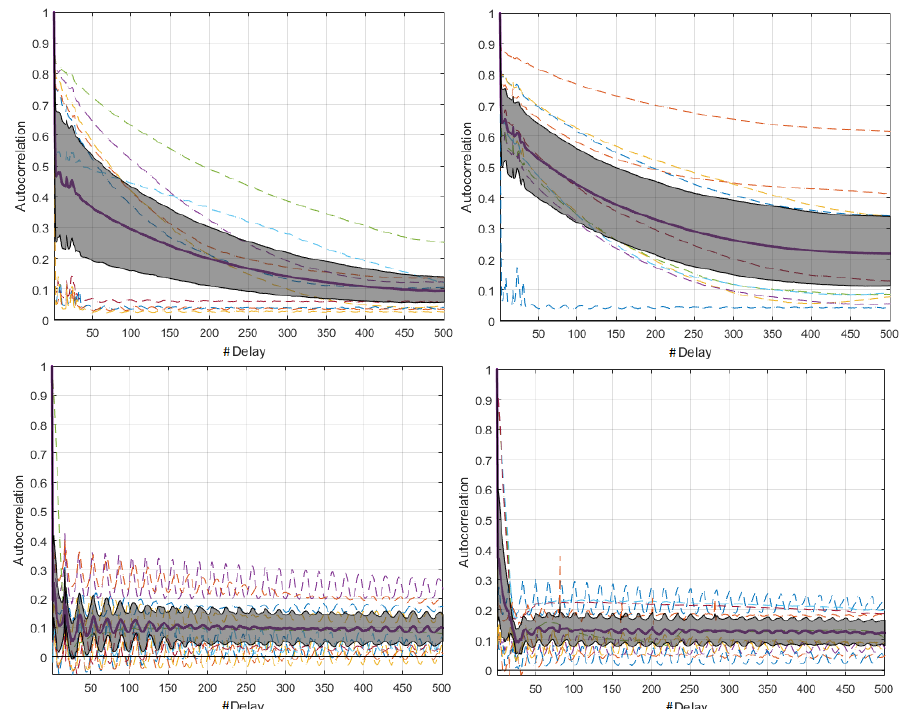
Figure 7. CI for SAF with distinctive characteristics for DigiMesh network: ( Left ) at 19,200 bauds; ( Right ) at 57,600 bauds; ( Top ) Coordinator Node; and ( Bottom ) Sensor Node